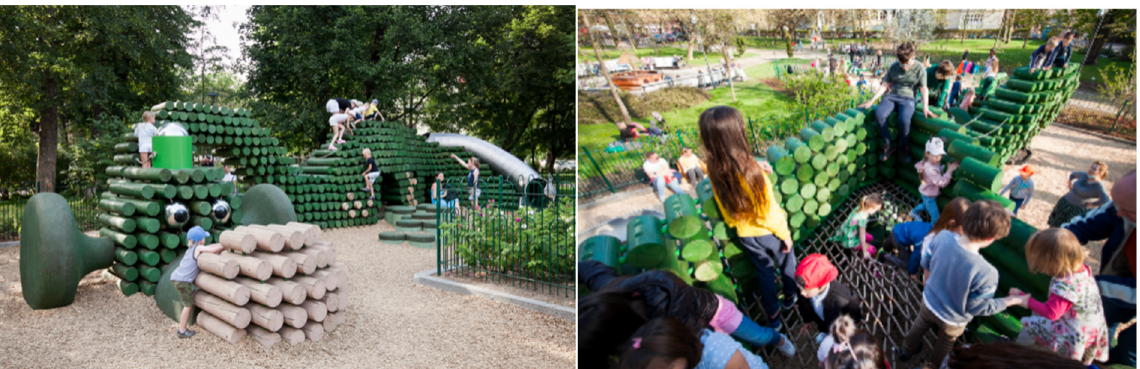
Figure 3. Lza Rutkowska Pri’s work “Dragon.” Reprinted with permission from Ref. [62]. Copyright 2021, Lza Rutkowska Pri.